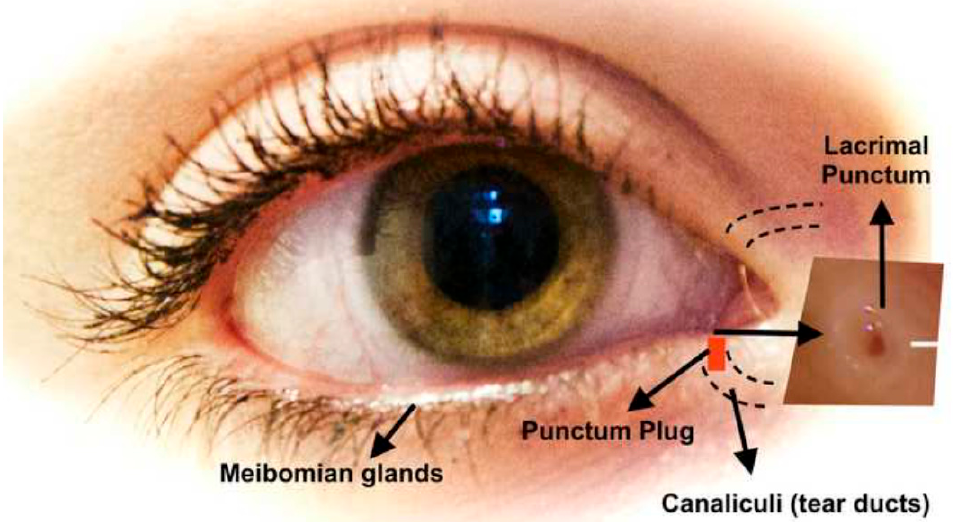
Figure 3. A view of punctum location and position of it in the eye. Adapted with permission from [36], Drug Discov. Today, 2015.